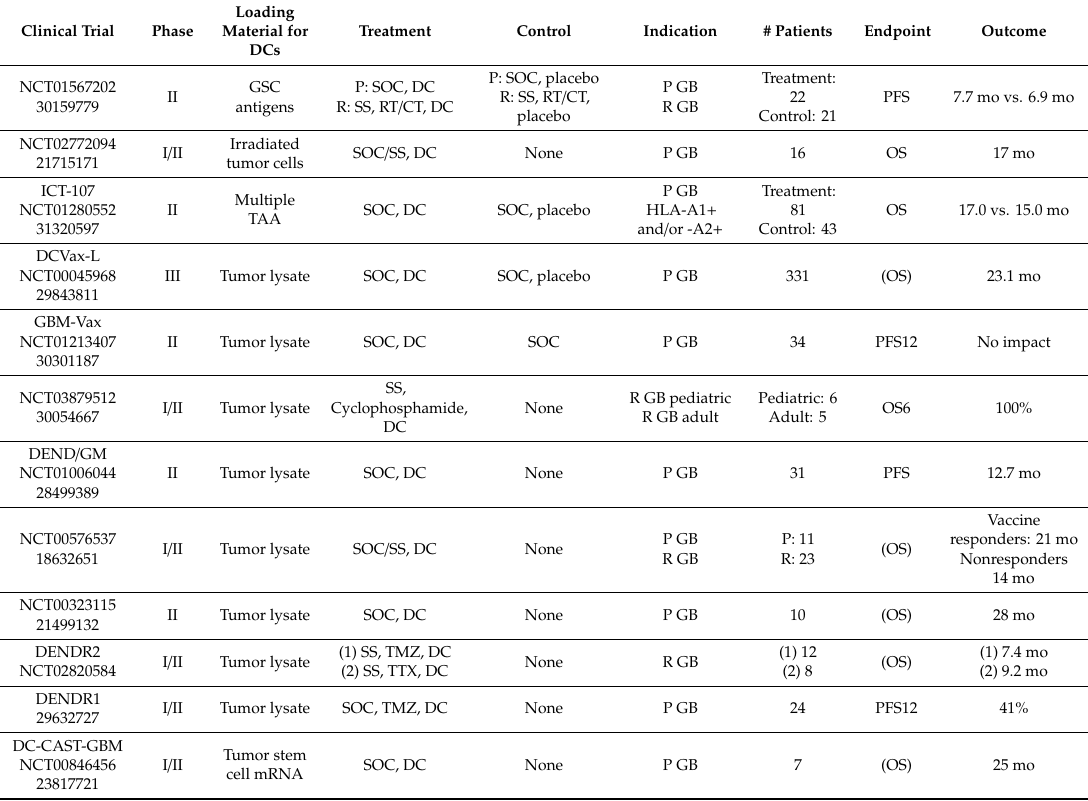
Table 3. Phase II / III clinical trials with dendritic cells (DC) vaccines in glioblastoma. Clinical